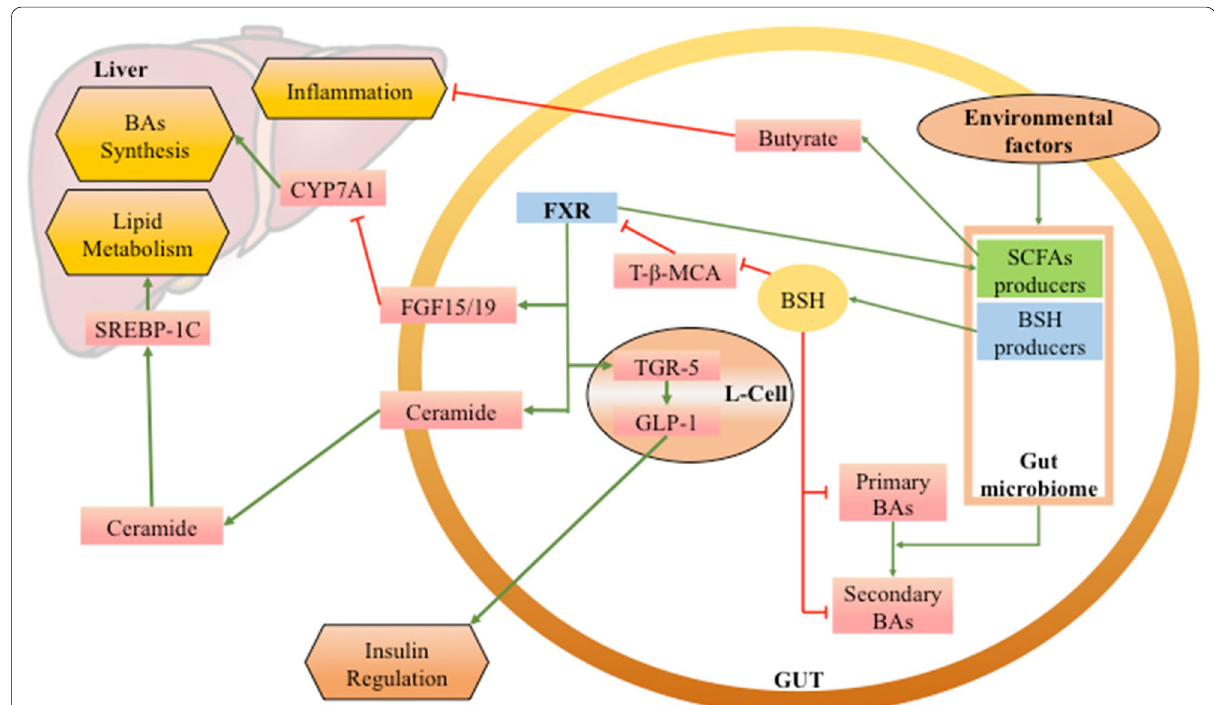
Fig. 1 The roles of FXR in the gut microbiome‑host system. Some of the mechanisms of the microbiome regulating inflammation, glucose metabolism, lipid metabolism and BA metabolism have been